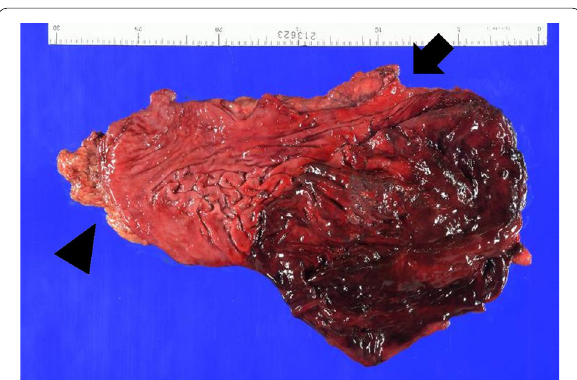
Fig. 3 Postoperative finding. Postoperative observation of the resected stomach was remarkable for necrotic and perforated fundus and corpus. Although the necrotic area extended to the vicinity of the cardia, the cardia (arrow) and pylorus (arrowhead) were